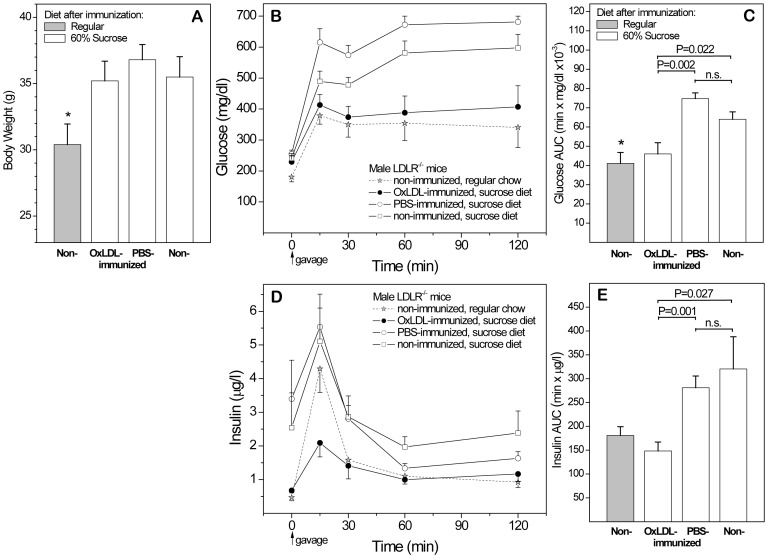
Protective effects of OxLDL immunization in male mice fed 60% sucrose.To assess direct effects of immunization with extensively oxidized LDL in immunized mice exposed to more obesogenic conditions, 4 month old male LDLR-/- mice immunized with OxLDL or PBS and controls were fed 60% sucrose for 38 weeks. Age-matched non-immunized mice fed regular chow served as additional control. (A) Body weights. (B,C) OGTT glucose response curves and AUCs. (D,E) Corresponding OGTT insulin curves and AUCs. n = 22.